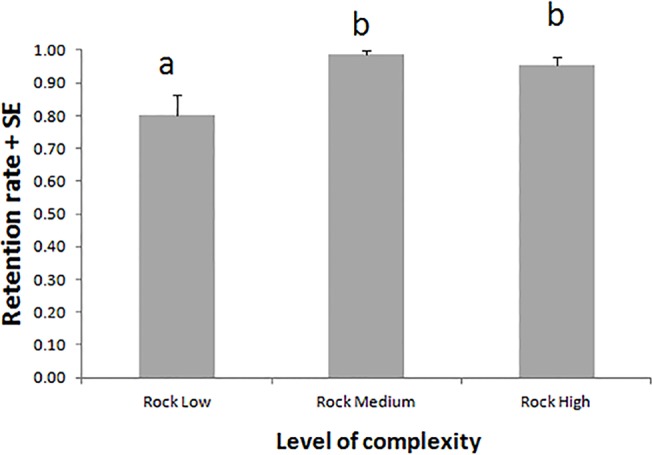
Effect of complexity on the ability of rocky substrates to retain seedlings (retention rate) under a moderate hydrodynamic regime.Letters above standard error bars indicate significant differences between treatment levels.